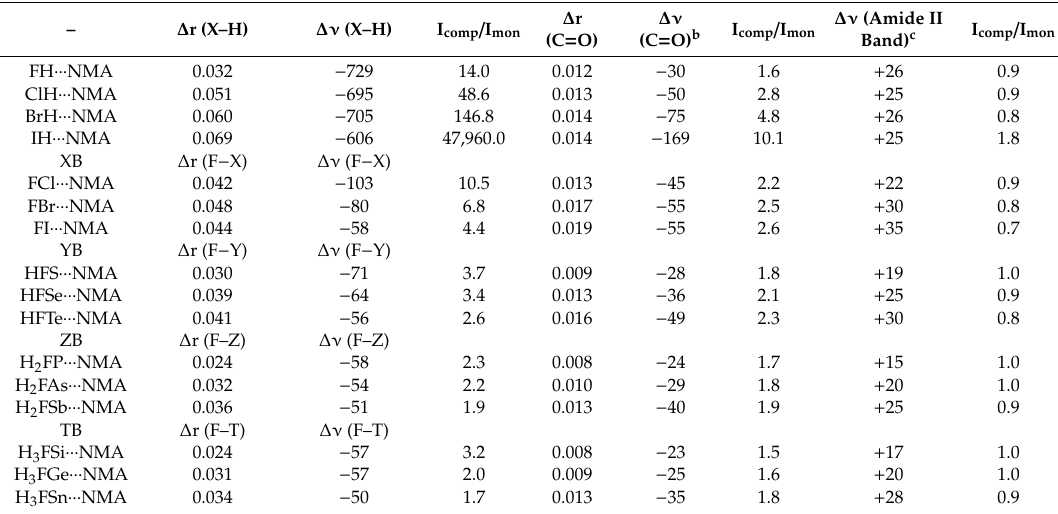
Table 1. Changes in internal bond lengths (Å), stretching frequencies (cm − 1 ), and band intensification resulting a from complex